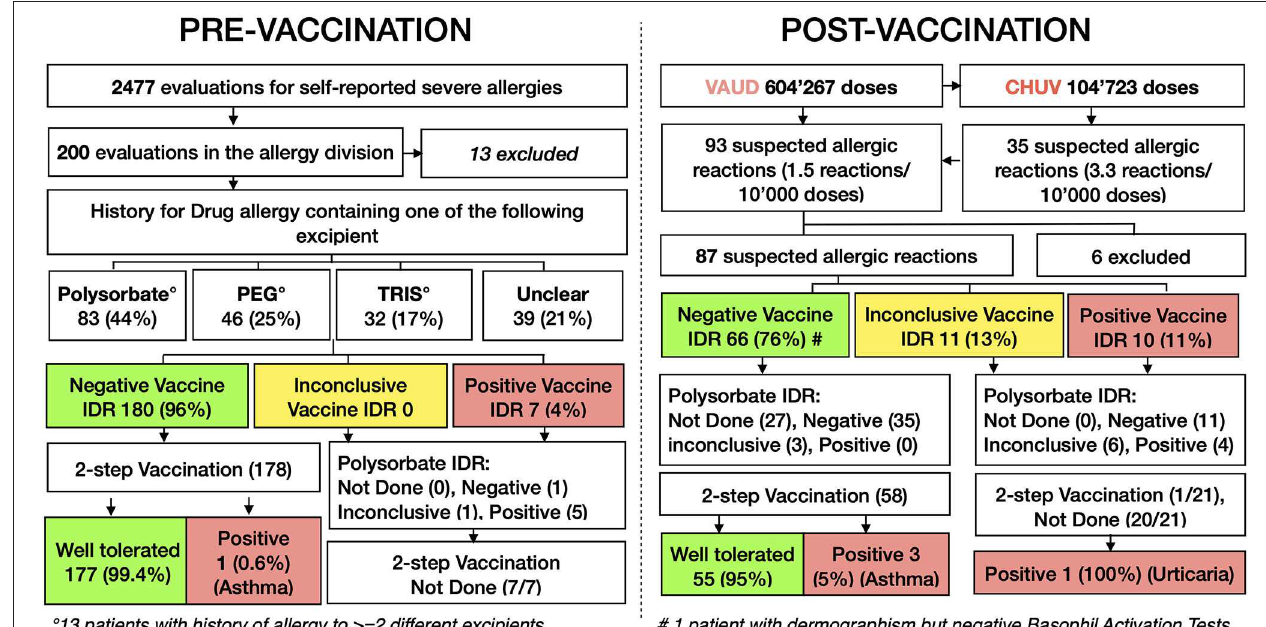
FIGURE 2 | Flow chart pre- and post-vaccination. Flow chart of individuals from the pre-vaccination and post-vaccination cohorts, which were evaluated in the division of allergy at the university hospital of Lausanne. PEG, polyethylene glycol; TRIS, trometamol; IDR, intradermal reaction.